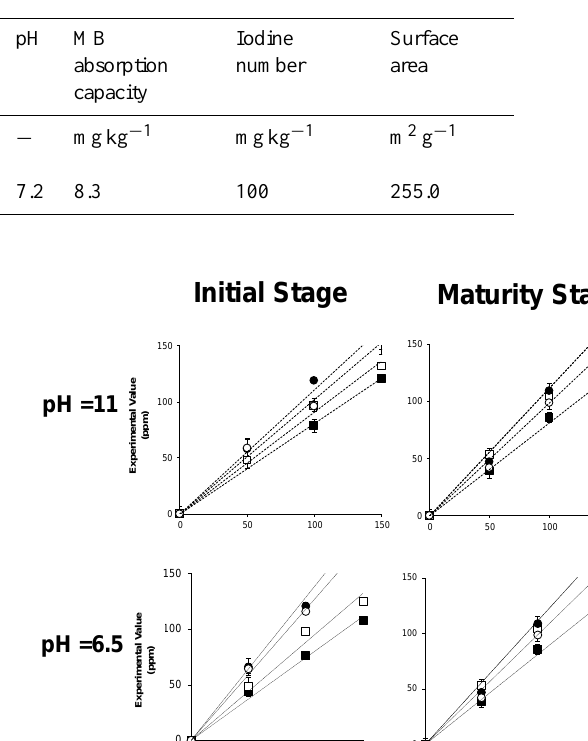
Added Value (ppm) Fig.2. Retention of PNP with different pH solution in the compost samples of poultry Figure 2. Retention of PNP with different pH solution in the com- manure PM ( □ ), poultry manure + biochar PM+B ( ■ ), poultry manure control PM- post samples of poultry manure PM ( (cid:3) ), poultry manure + biochar C( ○ ), and poultry manure + biochar control PMB-C ( ● ) during the composting process. PM+B ( (cid:4) ), poultry manure control PM-C ( (cid:13) ) , and poultry ma- nure + biochar control PMB-C ( • ) during the composting process.